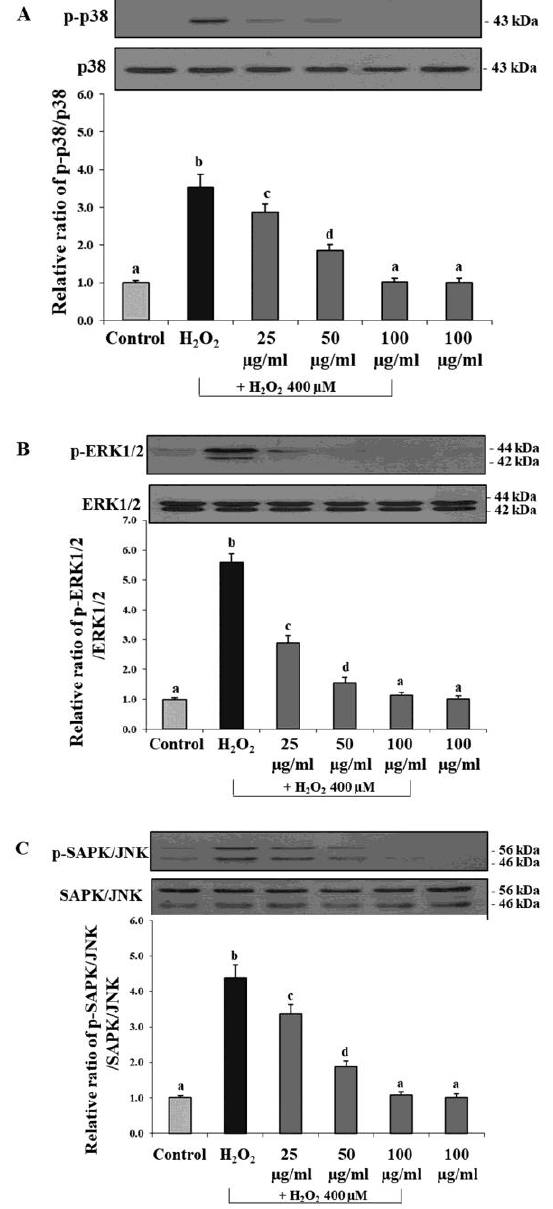
Figure 7. Evaluation of the effect of compound 3 on MAPK protein expression in oxidative-stress- induced ARPE-19 cells. Cells were pre-incubated with compound 3 at 25, 50 and 100 µg/mL for 24 h, followed by incubation with H 2 O 2 at 400 µM for 60 min. The protein expression levels of phosphorylated p38 ( A ), ERK1/2 ( B ), and SAPK/JNK ( C ) were determined by immunoblotting from cellular lysates. The densitometry values of the phosphorylated forms of p38, ERK1/2, and SAPK/JNK were normalized to the total form bands of p38, ERK1/2, and SAPK/JNK, respectively. Results are presented as mean ± SD values ( n = 4). Different superscript letters (a–d) indicate significant differences between values in the column ( p <